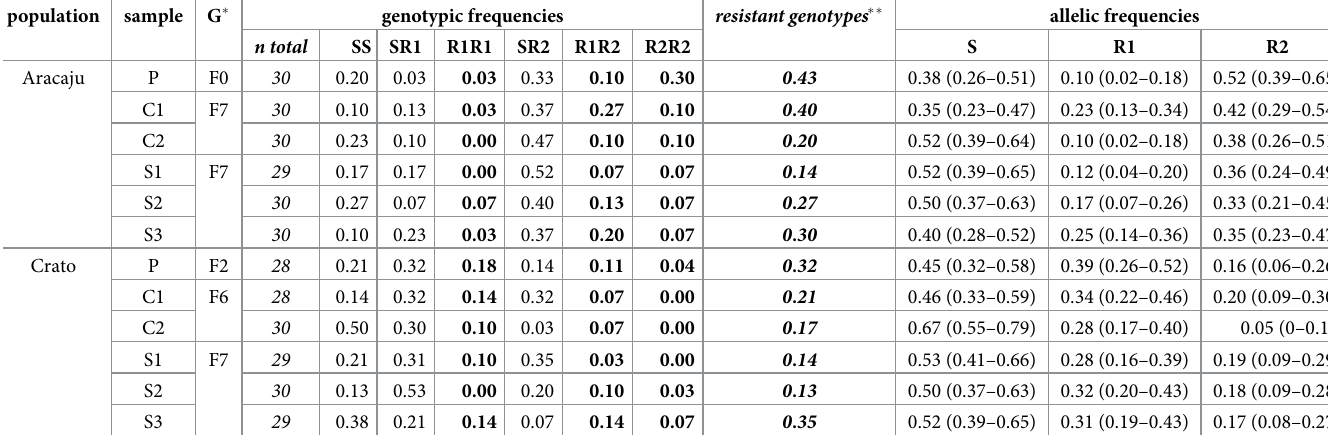
Table 2. Changes in the voltage-gated sodium channel (AaNa V ), target of pyrethroids, in Aracaju and Crato, during the malathion selection process. population sample G (cid:3)